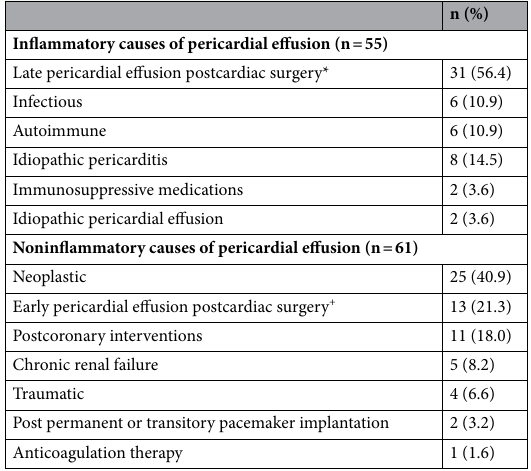
1 Table 2. Specific inflammatory and noninflammatory causes of pericardial effusion. *Late pericardial effusion postcardiac surgery was defined as pericardial effusion that presented ten days after surgery related to postpericardiectomy syndrome. + Early pericardial effusion postcardiac surgery was defined as pericardial effusion that presented during the first ten days after surgery.